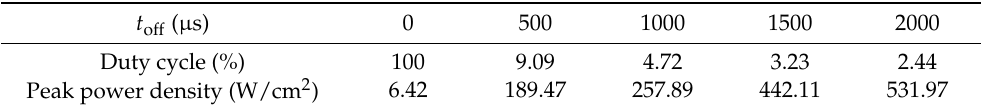
Figure 1. The sputtering voltage and current with different sputtering pulse off-times ( t off ): ( a ) 0 µ s, ( b ) 500 µ s, ( c ) 1000 µ s, ( d ) 1500 µ s, and ( e ) 2000 µ s. Table 2. The variation of duty cycle and peak power density as a function of t off used in each experiment ( t on = 50 µ